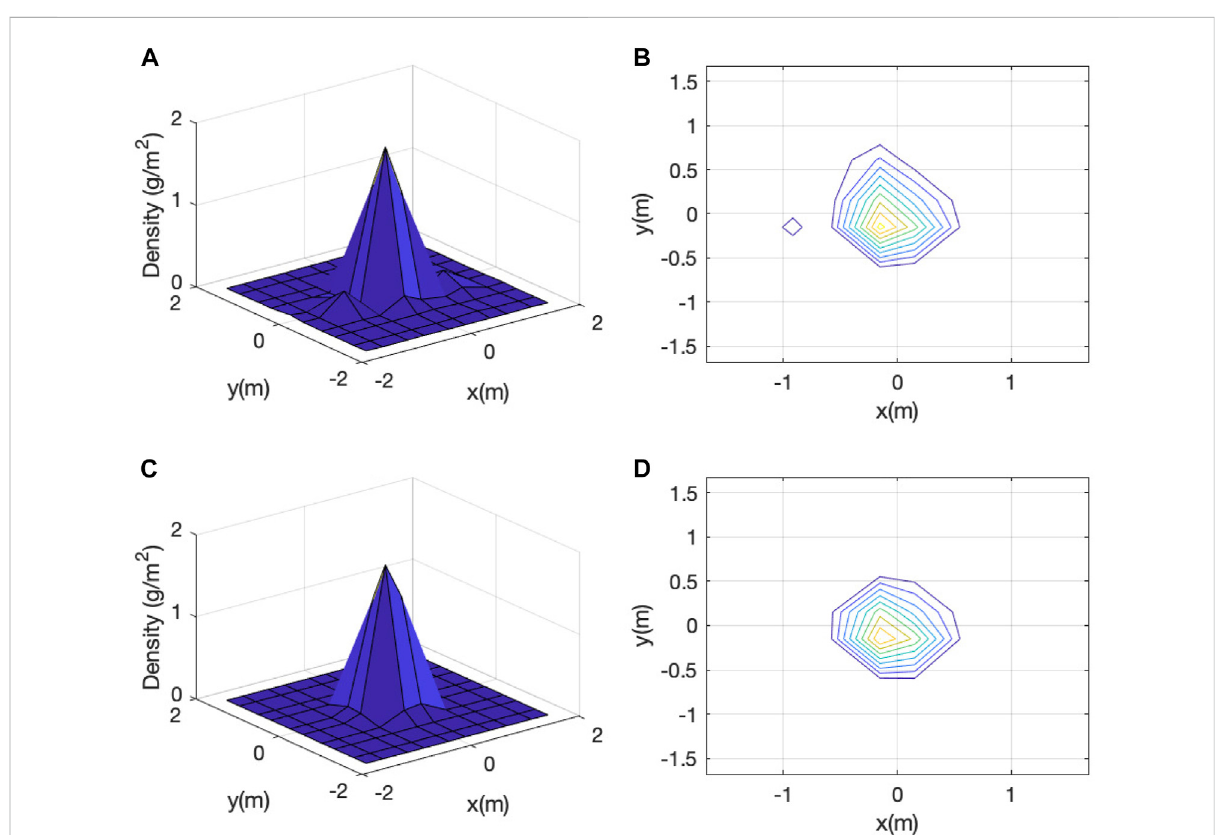
FIGURE 10 Raw vermiculite density data, (A) and (B) , versus its fi tted Gaussian distribution using linear regression, (C) and (D)